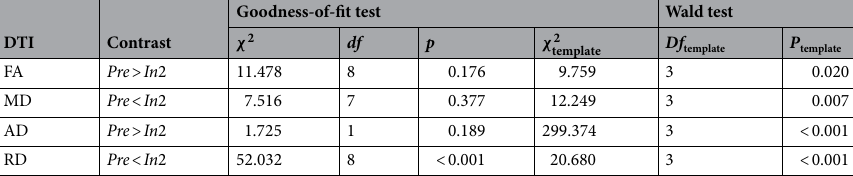
Table 3. Summary of Hosmer Lemeshow Goodness-of-Fit test and logistic analysis for the effect of the selected template on the ratio of the number of significant voxels (from the permutation-based t -statistical maps) and total number of voxels on the TBSS skeleton within the ROI (see Supplementary Tables S1-S4